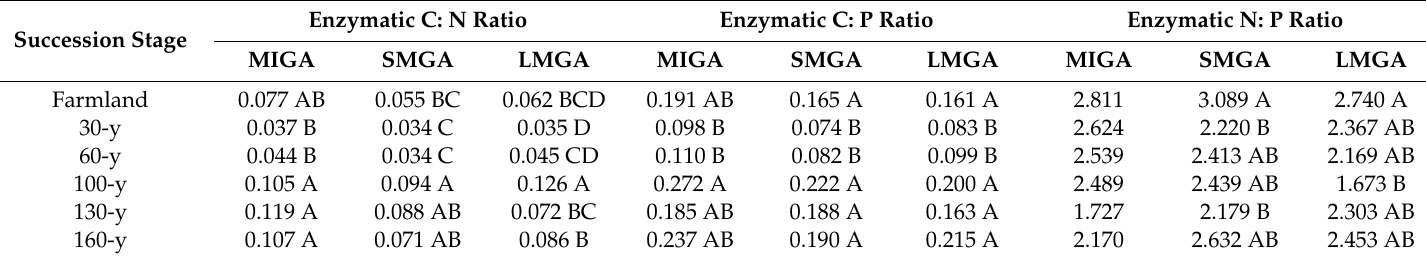
Table 3. E ff ects of di ff erent particle size aggregates on the enzymatic stoichiometry of topsoil in di ff erent succession